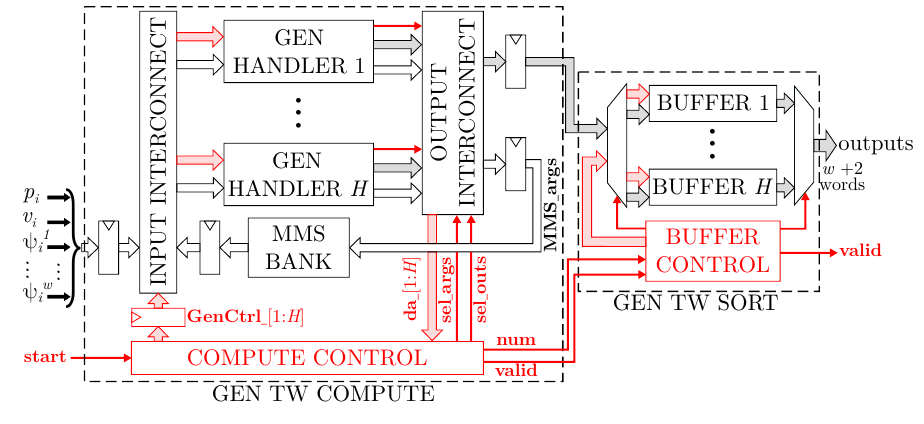
Figure 5: Generation of twiddles (GEN TW)